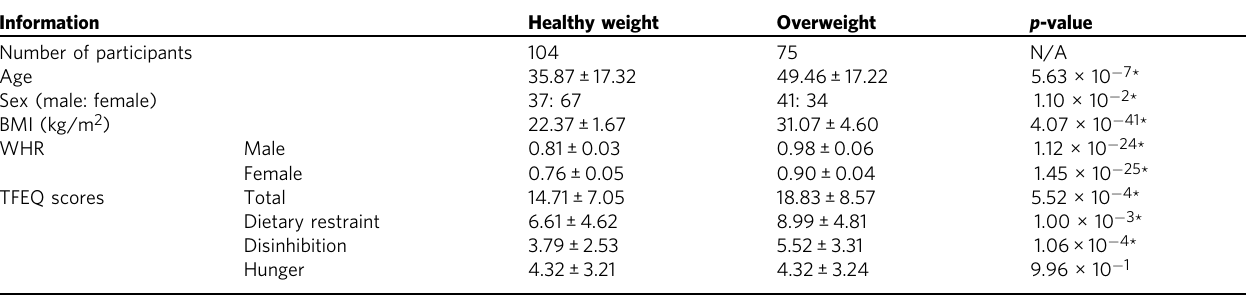
Table 2 Demographic information of study participants of healthy weight (18.5 ≤ BMI < 25 and WHR ≤ 0.85/0.9 for female/ male) and overweight (BMI ≥ 25 and WHR > 0.85/0.9)